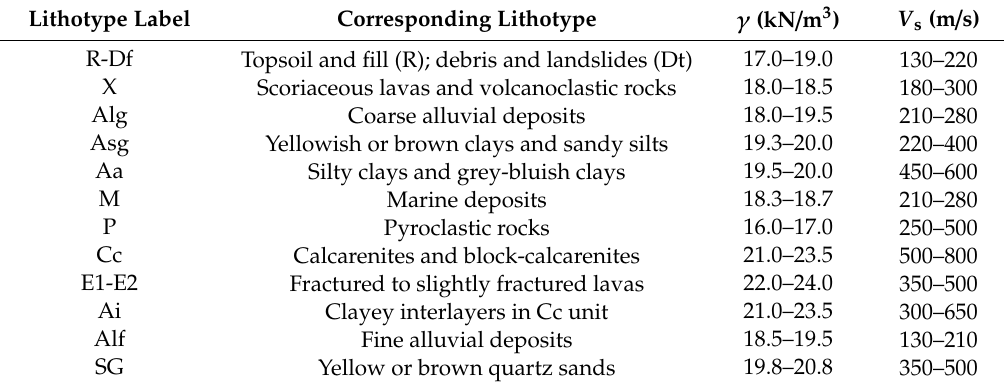
Table 1. Characteristic values of some representative geotechnical parameters [29].